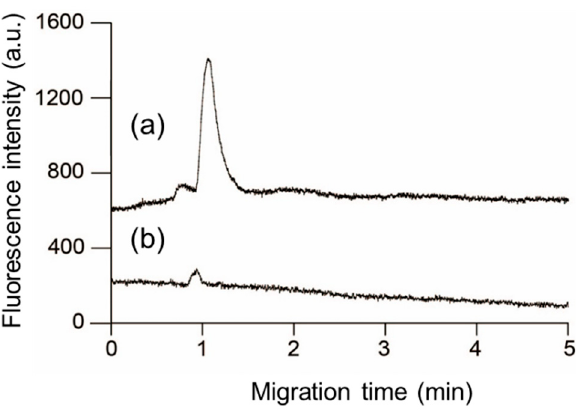
Figure 6. Electrophoretic separation of 5-(4,6-dichlorotriazinyl)aminofluorescein (DTAF)-labeled monophosphorylated β -casein after online preconcentration and derivatization at the channel cross- ing in the polydimethylsiloxane/glass microchannels with in situ fabricated Phos-tag acrylamide gel ( a ), and utilizing alkaline phosphatase to dephosphorylate β -casein ( b ).